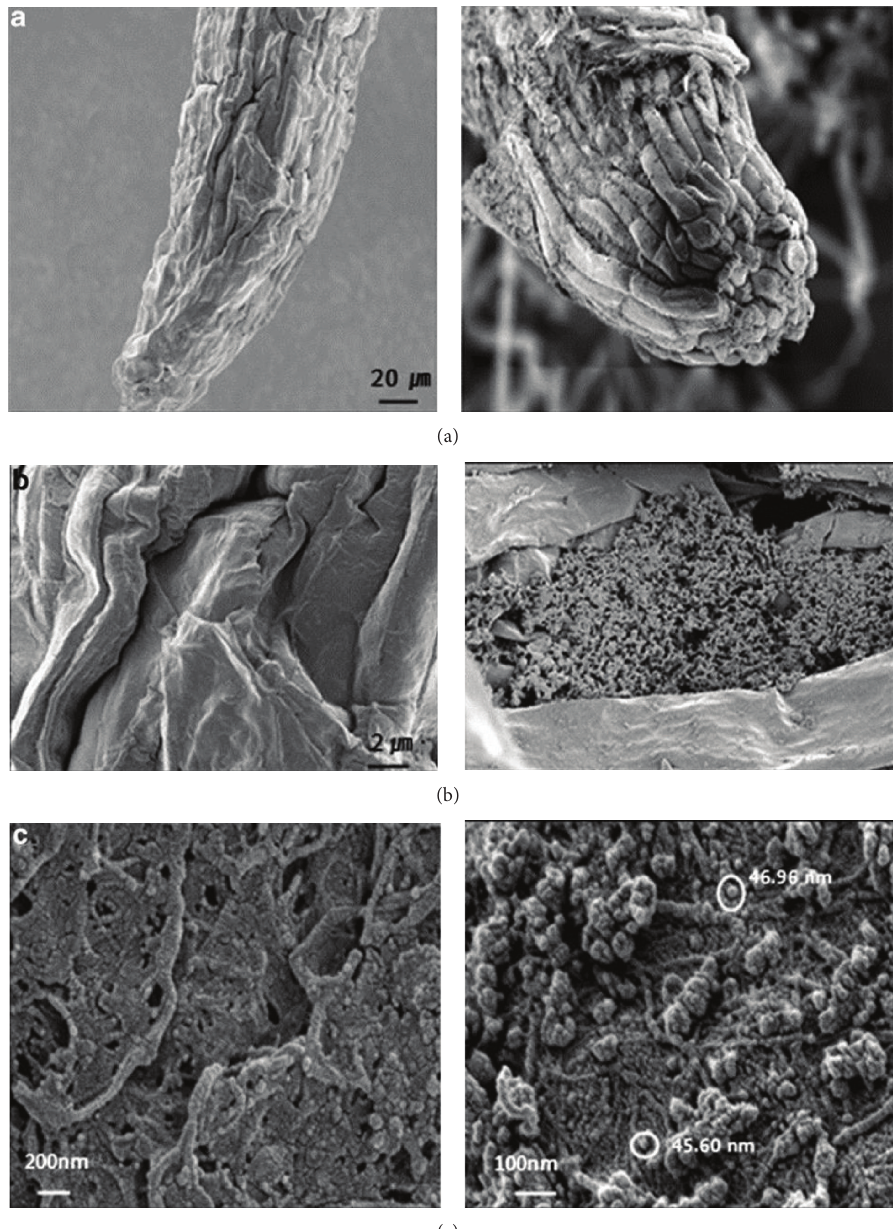
Figure 10: Scanning electron microscope images of Buckwheat (Fagopyrum esculentum) root surface under control (left) and treatment (right) with ZnO nanoparticles (1,000mgL −1 ) at a magnification of × 1,000 (a), × 5,000 (b), and × 150,000 (c)